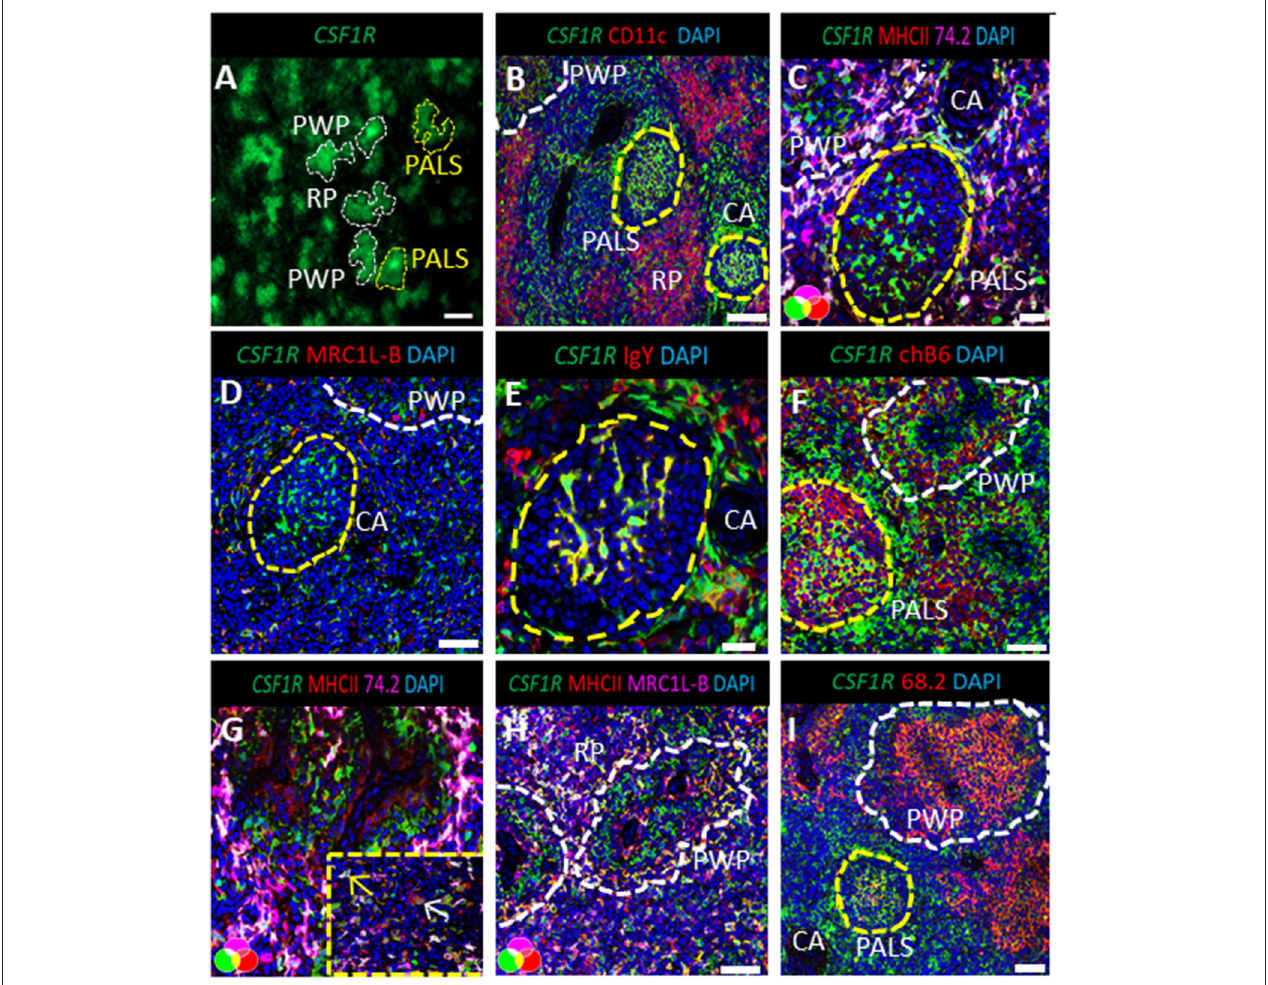
FIGURE 1 | CSF1R -tg + mononuclear phagocytes differentially express MRC1L-B and CD11c in the spleen. The white pulp of the chicken spleen consists of two morphologically distinct areas, the peri-arteriolar lymphoid sheaths (PALS) that surround the central artery (CA) and the peri-ellipsoid white pulp (PWP) surrounding the penicillary capillaries. (A) Whole mount microscopic analysis of the spleen demonstrates the abundance of CSF1R -tg + cells in the PALS and PWP; (B) CD11c is differentially expressed across the PALS and PWP and high concentrations of CD11c hi cell sheaths were observed in the red pulp (RP); (C) the chicken macrophage marker, Ch74.2, is expressed by a majority of the CSF1R -tg + MHCII + PALS-associated mononuclear phagocytic cells in contrast to the FDC and the EAC in the PWP; (D) CSF1R -tg + cells surrounding the CA express MRC1L-B while some scattered CSF1R -tg + PALS-associated mononuclear phagocytic cells lack MRC1L-B expression which is also observed in FDC; (E) FDC and plasma cells express IgY; (F) GC are packed with chB6 + B cells and chB6 + B cells surround the ellipsoid in the PWP; (G) in the PWP, Ch74.2 + EAM reside in the outer regions of the PWP and in the red pulp, not all CSF1R -tg + cells express this chicken macrophage marker [insert image of Ch74.2 + (yellow arrow) and Ch74.2 neg (white arrow) staining in red pulp macrophages]; (H) EAM express MHCII and MRC1L-B in contrast to the EAC; (I) CSF1R -tg is expressed by the Ch68.2 + EAC. Yellow dashed circles indicate GC, white dashed lines indicates the PWP. Data is representative of five CSF1R